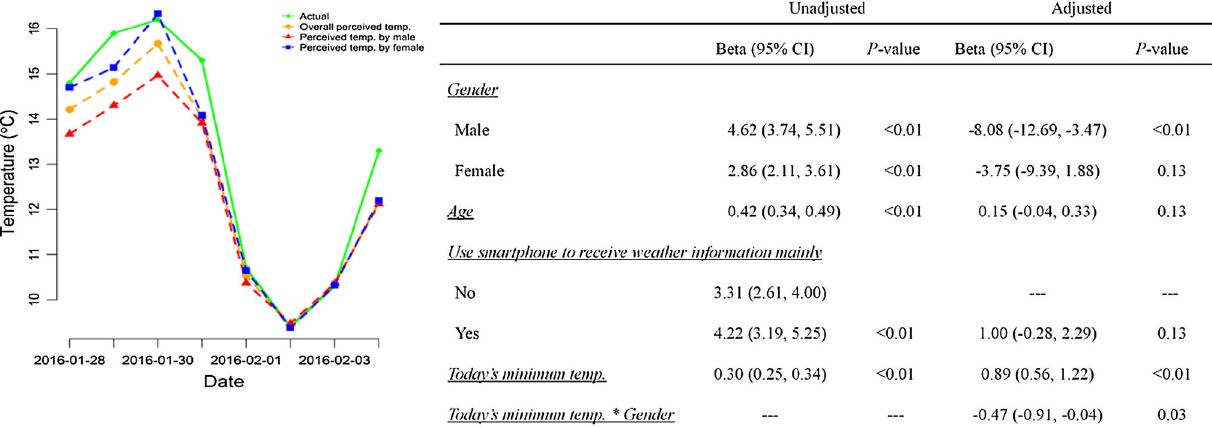
indicated they knew the minimum temperature were included in the regression; CI confidence